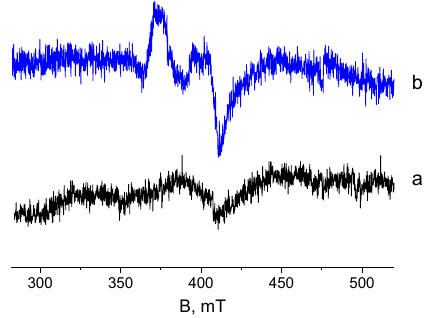
Figure 9. EPR spectra of TiO 2 /WO 3 photocatalyst before ( a ) and after 10 min ( b ) of UV light illumination.